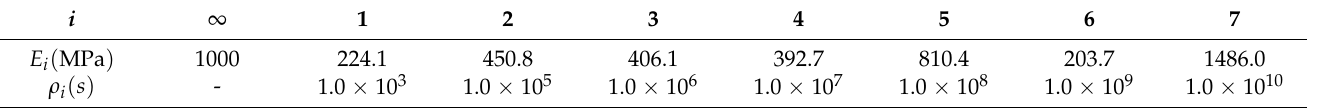
Table 2. Relaxation times and Prony coefficients for PMT-F4